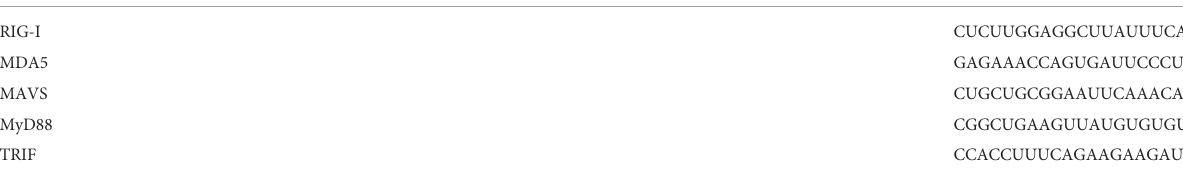
TABLE 2 Short interfering RNA target